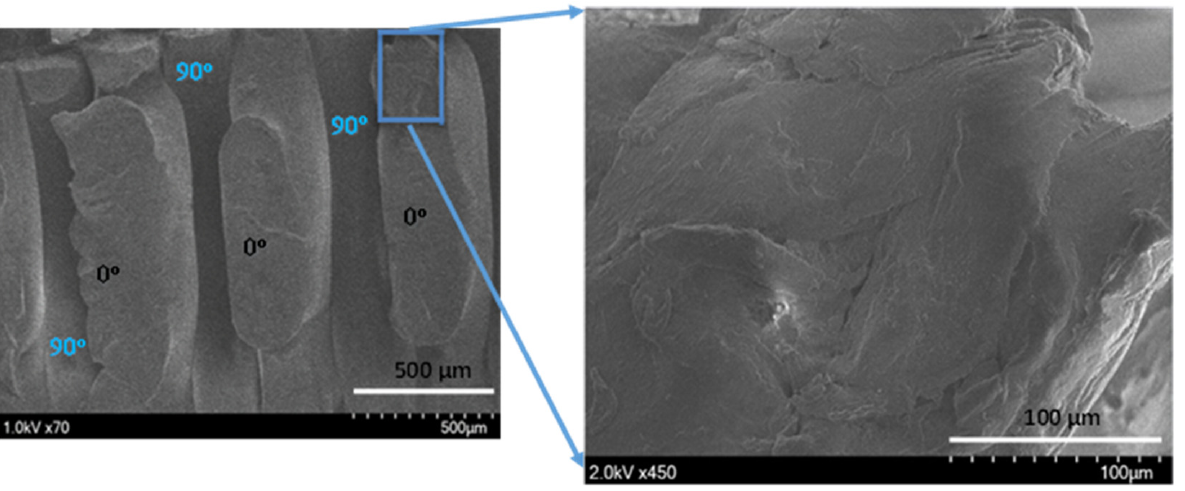
Figure 12. Scanning electron microscope snapshot of shear zone in the 0 o /90 o orientation with a 20.83° shear angle (left). Close up of shear zone of 0 o filament (right).